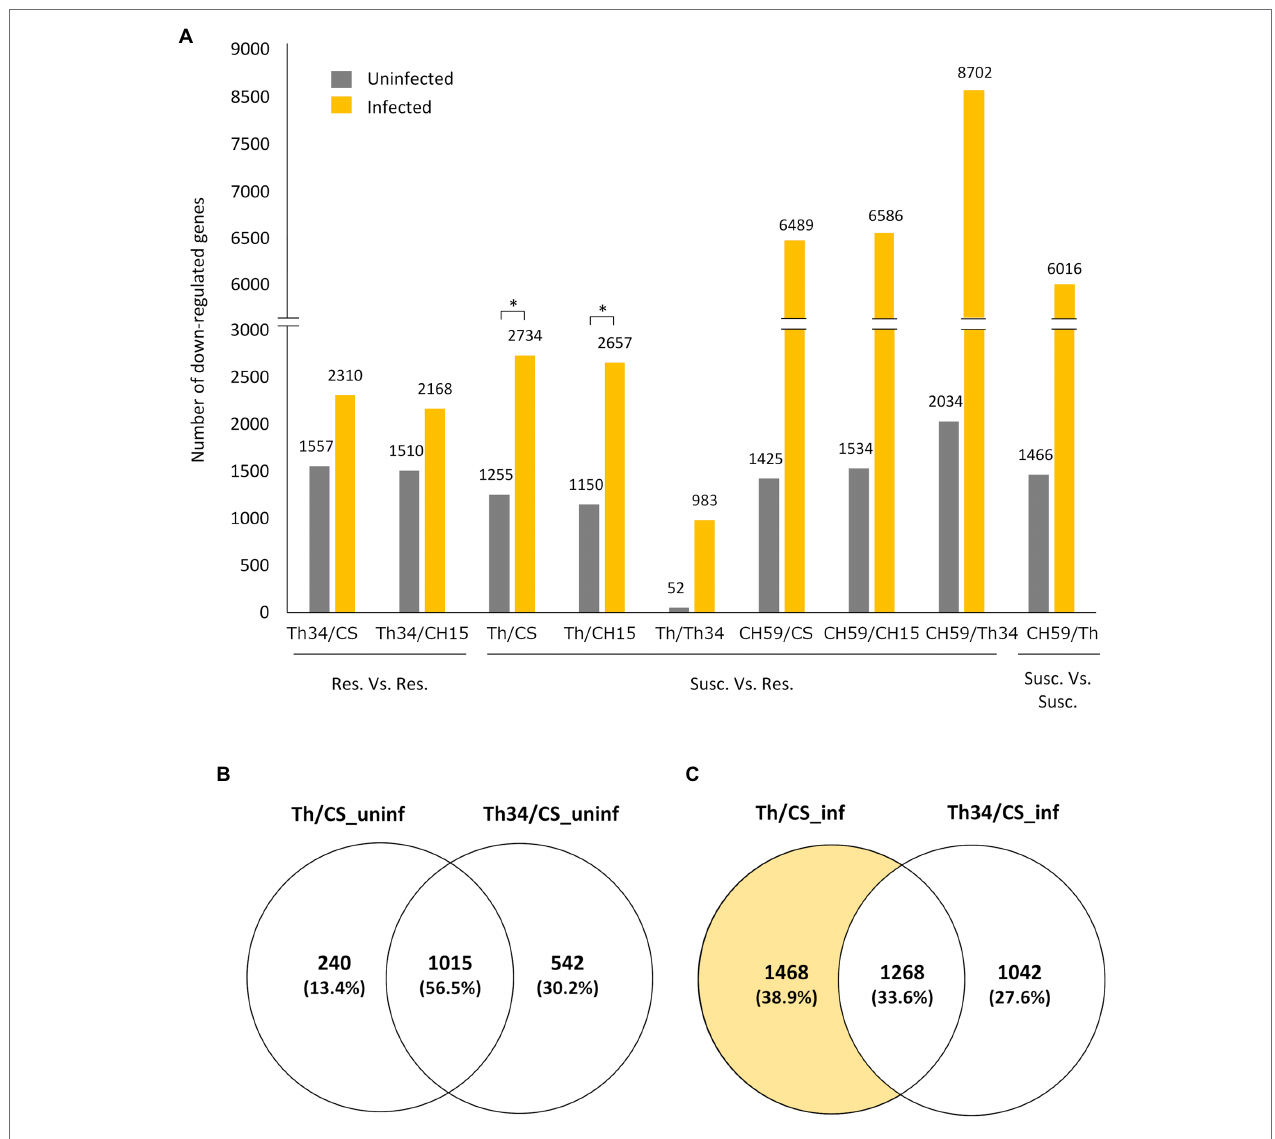
FIGURE 2 | Quantitative analysis of differentially expressed genes in wheat lines. (A) Bar plot showing the number of genes that are downregulated (log2-fold change > |1.0|, adjusted p value [FDR] < 0.05) between different wheat lines under control (uninfected) and infected conditions. Pairwise comparisons are indicated on the x -axis, and the number of genes is always referred to the first line. For example, in the comparison Thatcher/Thatcher- Lr34 , we found that 52 and 983 genes are downregulated in Thatcher under uninfected and infected conditions, respectively. Asterisks indicate statistically significant increase of downregulated genes in Th/CS ( p < 0.05) and Th/CH15 ( p < 0.05) compared to Th34/CS and Th34/CH15, respectively, under infected conditions. (B,C) Venn diagrams illustrating the genes found to be downregulated in Thatcher and Thatcher- Lr34 in comparison to Chinese Spring, under uninfected and infected conditions. Wheat lines: Thatcher (Th), Thatcher- Lr34 (Th34), Chinese Spring (CS), AUS 27378 (CH15), and AUS 27438